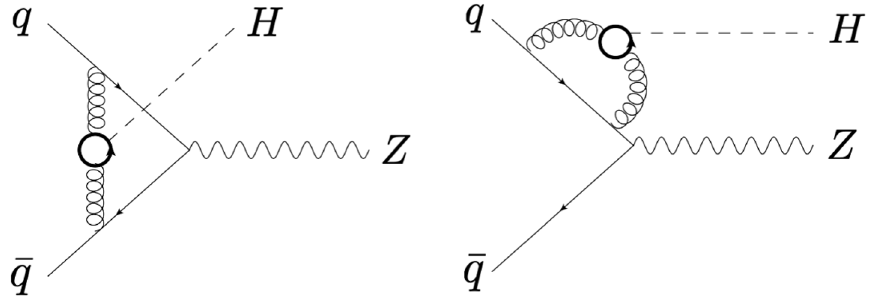
Figure 8 . The two-loop class-I diagrams of the top contributions to q (cid:22) q ! ZH proportional to (cid:21) t . The thick solid lines denote the massive top